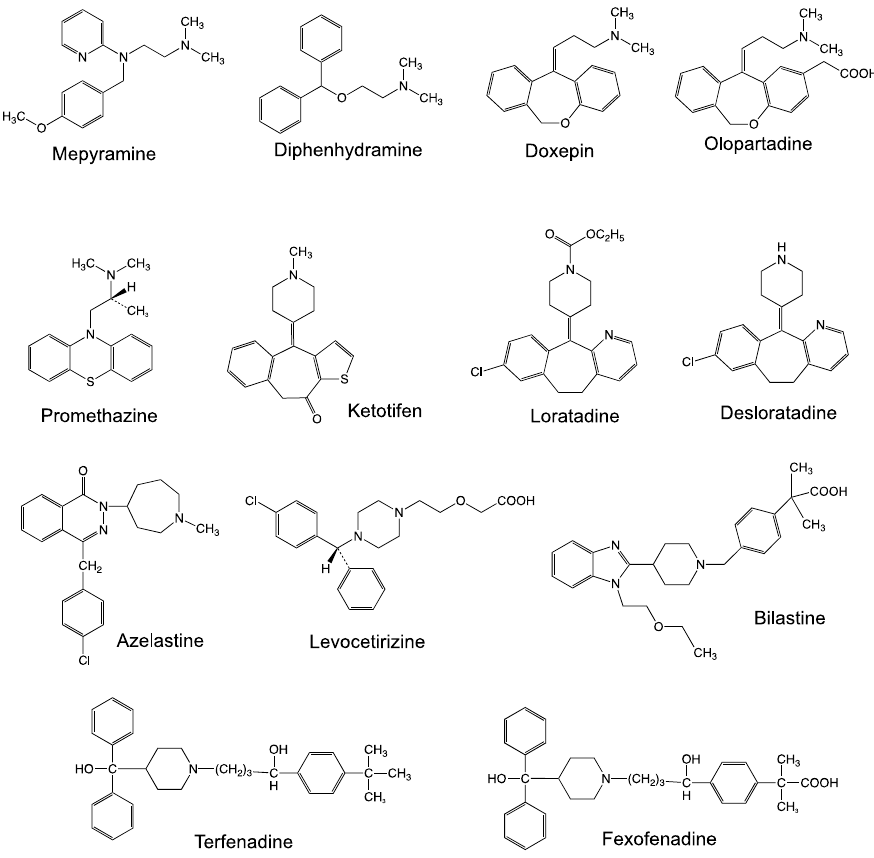
Figure 1. Chemical structure of the antihistamines evaluated in this study.